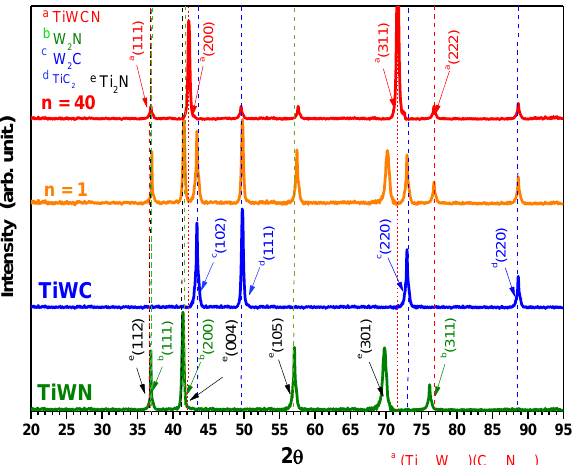
Figure 1. XRD patterns of the Ti-W-N, Ti-W-C monolayer coatings, and n = 1 and n = 40 multilayer coatings deposited by RF magnetron sputtering. deposited by RF magnetron